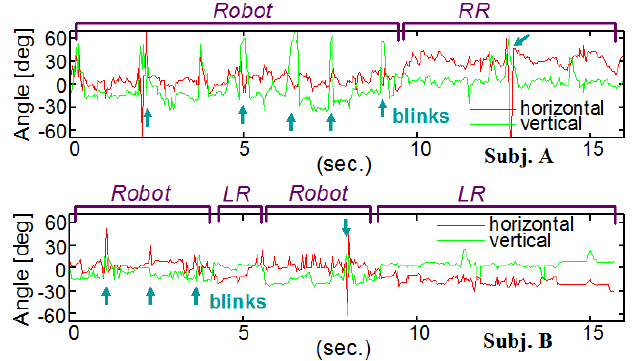
region. The robot itself has also the assigned multimodal data sets for eye-contact reactions.